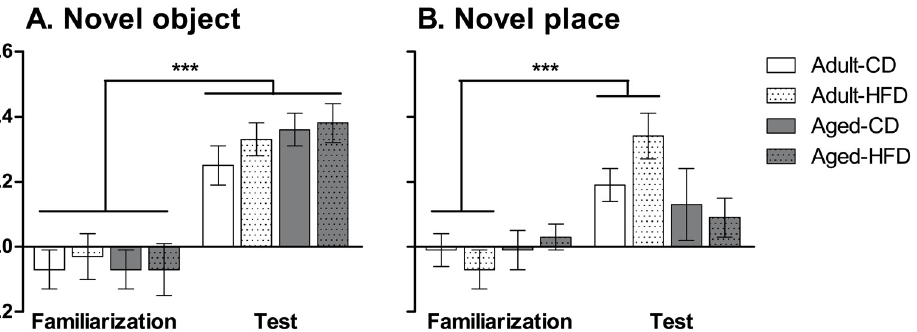
Fig 3. Effects of aging and exposure to high-fat diet on novel object and novel place recognition memory. Novel object ( A ) and novel place ( B ) recognition tasks in adult and aged mice on control diet (CD) or high-fat diet (HFD). Aged mice showed impaired novel place performance compared with adult mice, reflected by a similar discrimination index ([novel — familiar] / total) in the familiarization phase compared with the test phase of the task. No significant effects of HFD were evident. The data are expressed as mean ± SEM. *** p < 0.001.